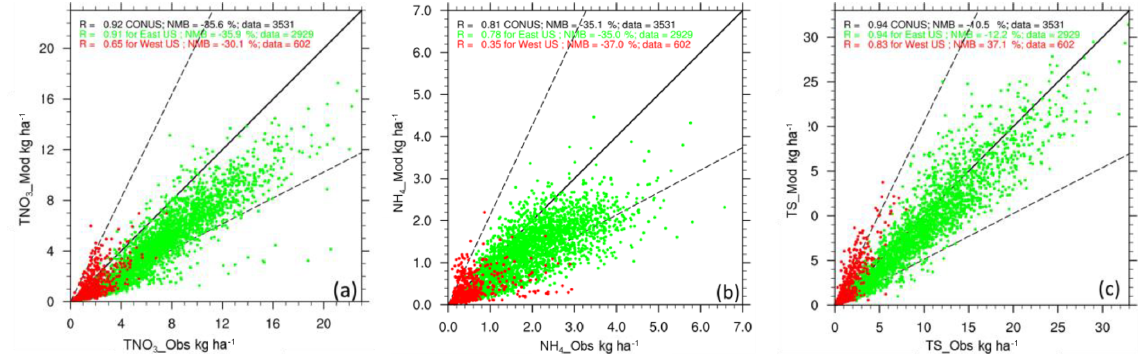
Figure 1. Scatter plots for the annual accumulated WDEP (total oxidized nitrogen (TNO 3 , a ), reduced nitrogen (NH x , b ), and total sulfate (TS, c )) between precipitation-adjusted model results and observations from 1990 to 2010 for 170 valid sites with 3531 valid data points. The data at each NADP are assumed to be valid for our analysis only if at least 18 years of observation data are available at that site and the data coverage is at least 75% for each year. Each point in the plots represents the annual accumulated WDEP for a given site and year. Note that the annual accumulated WDEP values used in this analysis may not be the actual annual totals due to missing data in the observations. The green color is for the eastern US, and the red color is for the western US, with the dashed line for the 1:2 and 2:1 ratio and the solid line for the 1:1 ratio. Table 2. Evaluation results for the 10 ecoregions for TNO 3 WDEP. The units are kgha − 1 for the means and MB and kgha − 1 yr − 1 for the trends. The bolded values indicate trends that are statistically significant, with the p value less than 0.05 for the standard Student’s t test. Mean ID Region name No. of sites